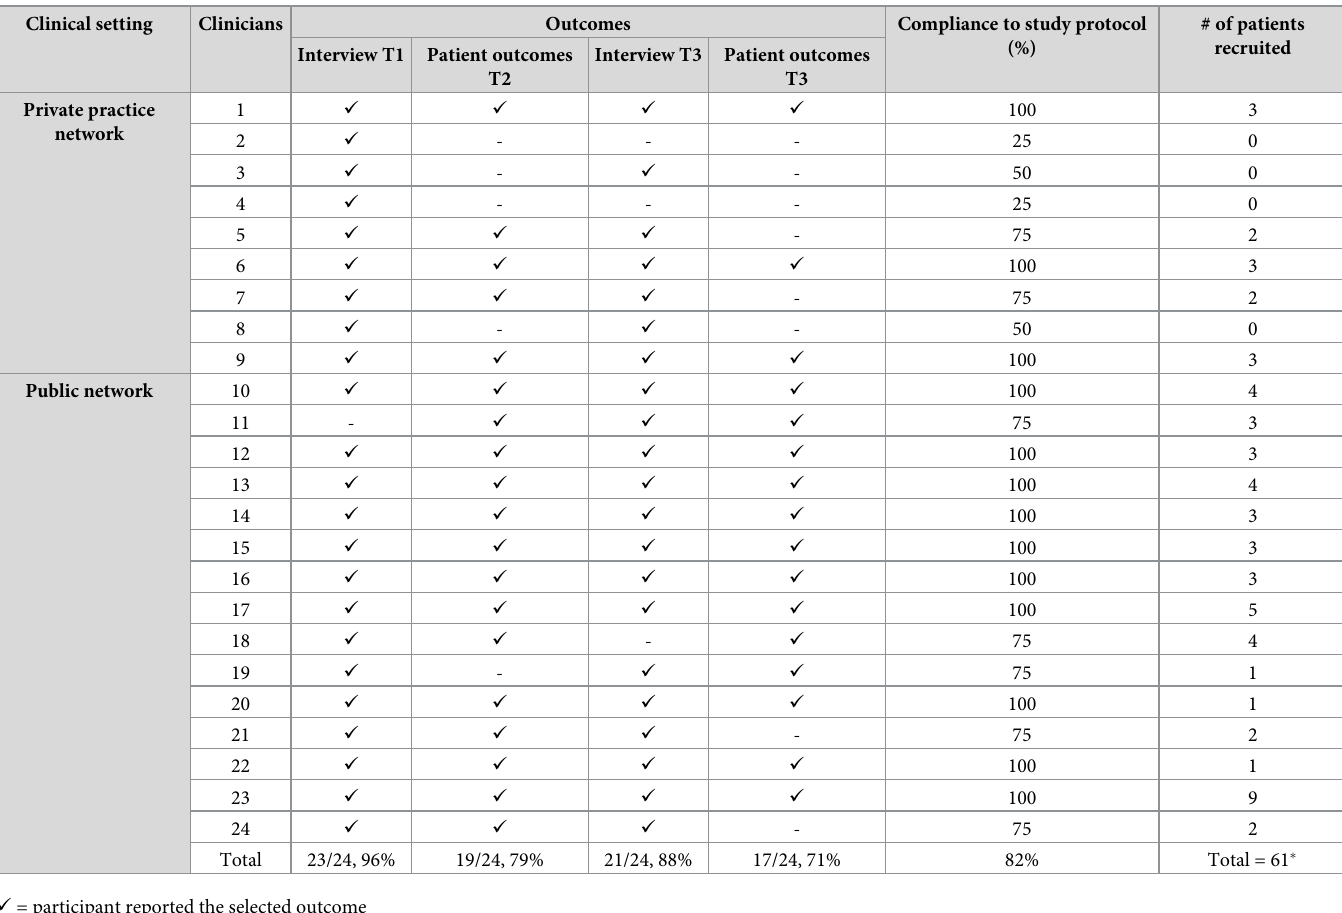
Table 4. Detailed feasibility outcomes for each participating clinical setting and clinicians. Clinical